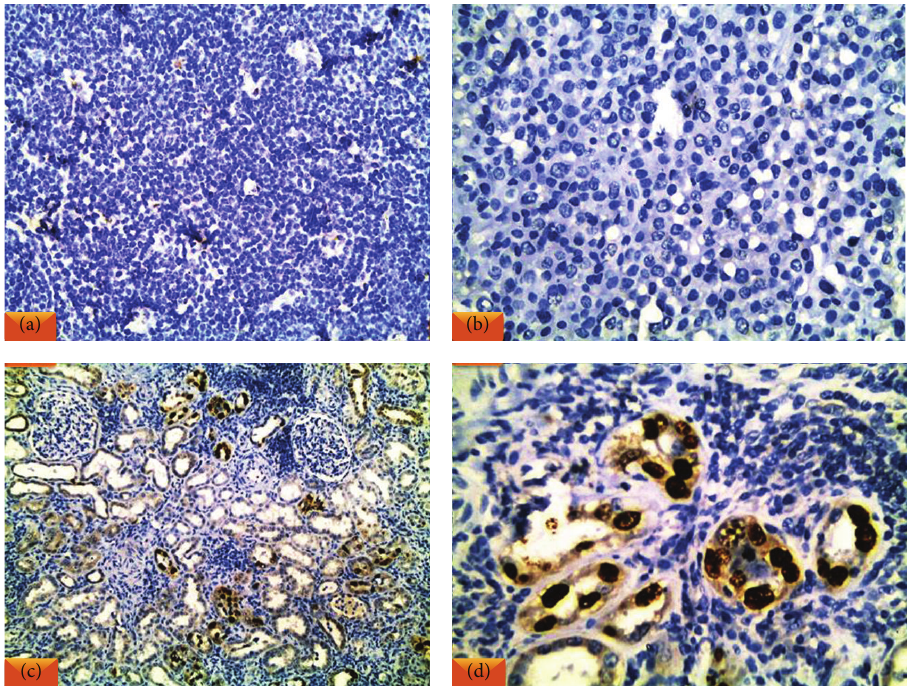
Figure 1: (a) Reactive follicular hyperplasia with prominent tangible body macrophages showed SV40 negativity. (b) Diffuse large B-cell lymphoma (DLBCL) displayed SV40 negativity. (c) SV40 infected renal tissue was the positive control. (d) High power view demonstrating the nuclear SV40 positivity in the tubular cells (IHC × 200 for (a) and (c) and × 400 for (b) and (d)).